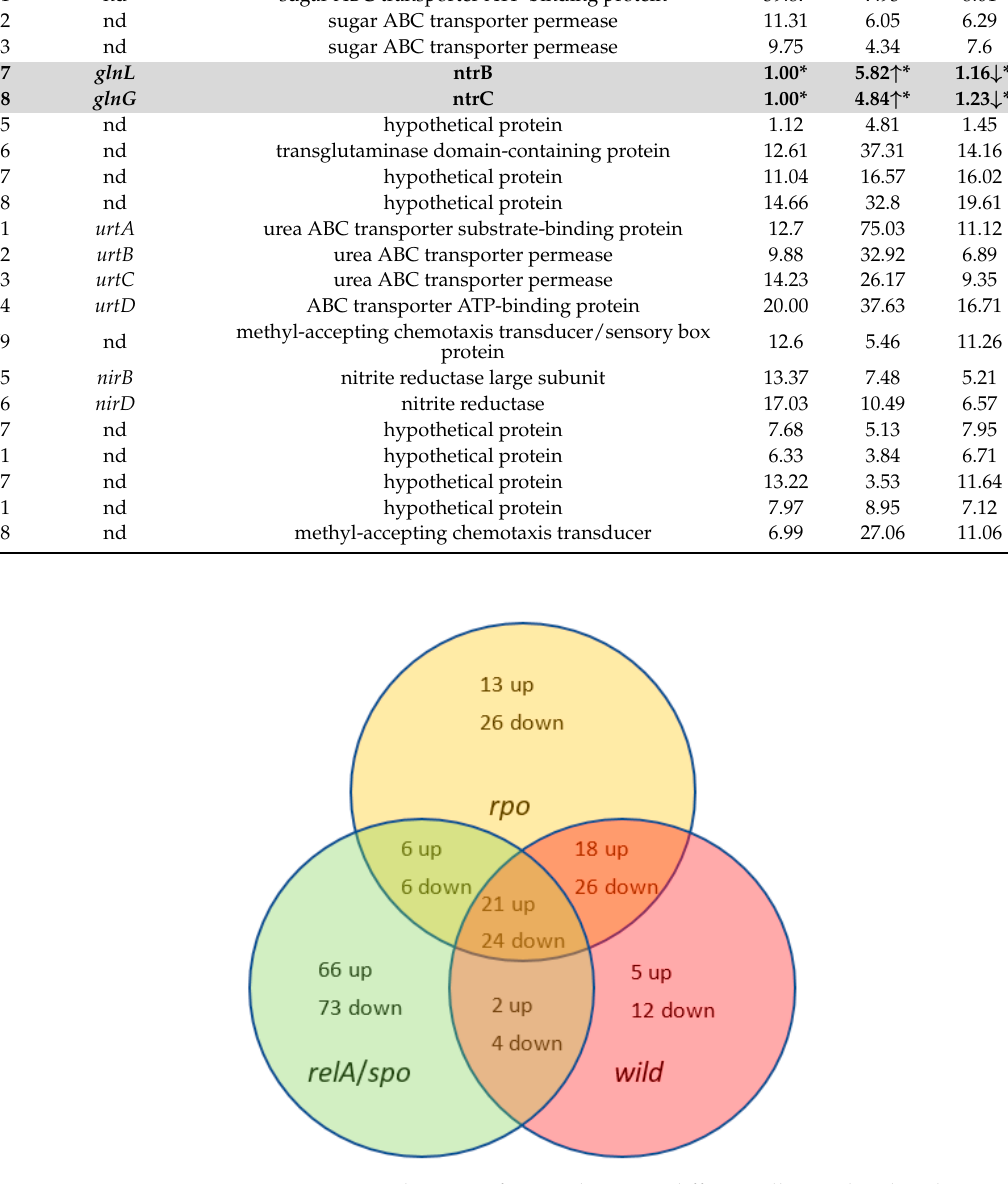
Figure 5. Venn diagram of genes that were differentially regulated under nitrogen limitation during growth of Pseudomonas putida KT2440 wild type ( wt ) and mutants ( relA / spoT and rpoN ). The directions of gene transcription changes resulting from nitrogen limitation are shown in Figure 6. The lowest number of genes showing statistically significant expres ‐ sion changes was noticed in wild type. The number of genes showing upregulation (46 genes) was lower than the number of genes showing downregulation (66 genes). Addi ‐ tionally, the fold change of downregulated genes was much higher than that of upregu ‐ lated genes. In relA / spoT mutant the numbers of genes showing upregulation and down ‐ regulation were similar (95 and 106, respectively). The values of fold changes were not higher than 40. The directions of transcription changes in rpoN mutant were similar to those of wild type. The number of genes showing upregulation (58 genes) was lower than the number of genes showing downregulation (81 genes). Similarly, to wild type the fold change of downregulation was much higher than upregulation.